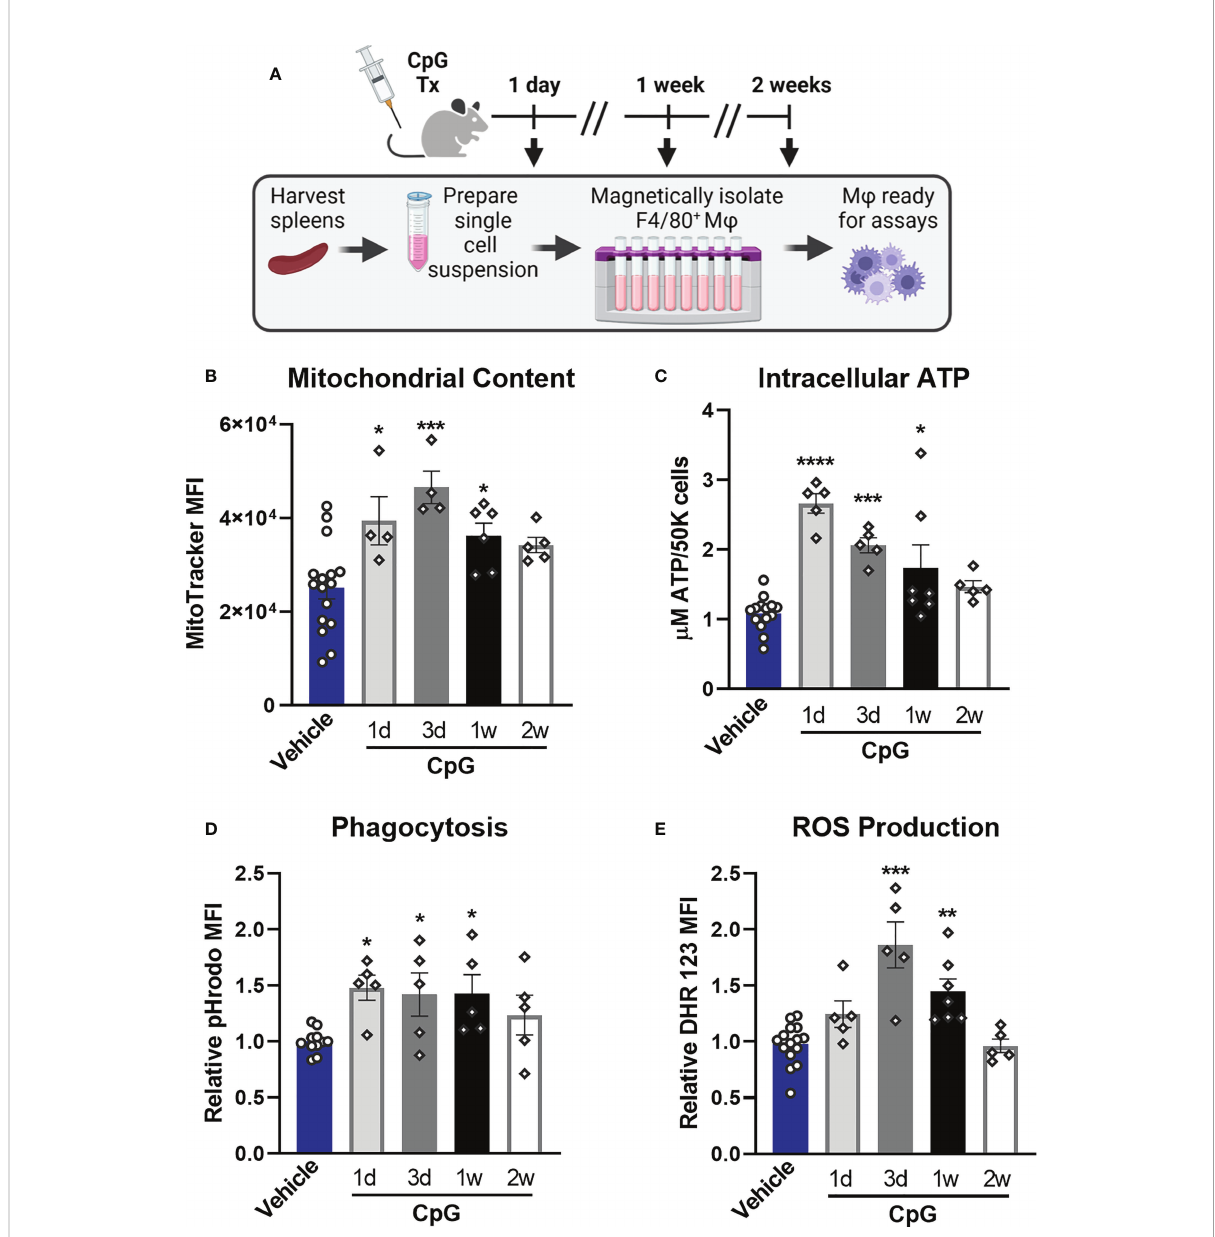
FIGURE 8 CpG induces macrophage metabolic and functional rewiring in vivo. (A) Mice were treated for two consecutive days with CpG (20 µg i.v. ) or vehicle (Lactated Ringers) and spleens were harvested 1-day (1d), 3-days (3d), 1-week (1w), or 2-weeks (2w) later. Spleens were processed for magnetic isolation of F4/80+ macrophages which were used immediately for respective assays. (B) Mitochondrial content was assessed by MitoTracker Green staining. (C) Intracellular ATP content was measured. (D) Relative phagocytic activity was assessed by emitted fl uorescence upon phagocytosis of pHrodo-tagged S. aureus bioparticles and measured by fl ow cytometry. (E) ROS production was determined by relative dihydrorhodamine 123 (DHR 123) fl uorescence. Data are shown as mean ± SEM, n = 5-16/group *p < 0.05, **p < 0.01, ***p < 0.001, ****p < 0.0001 by ANOVA followed by Dunnett ’ s post-hoc multiple comparison